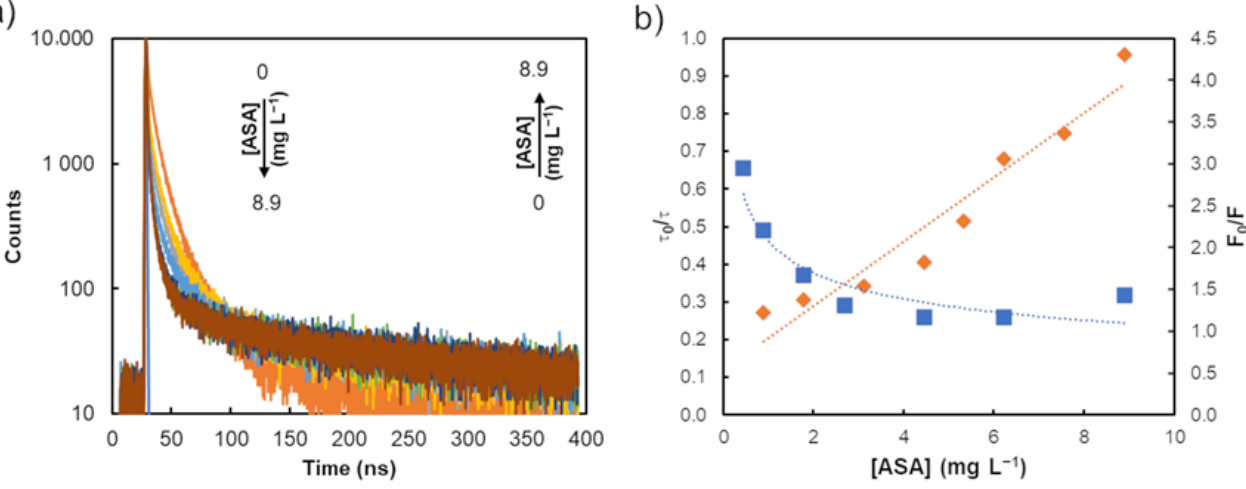
Figure 6. ( a ) Time-resolved PL decay curves of the MES-CdTe QDs ( λ em = 599 nm) in the presence of increasing concentration of aspirin. ( b ) Ratio of PL lifetimes (blue squares) and PL intensity (or- ange diamonds).